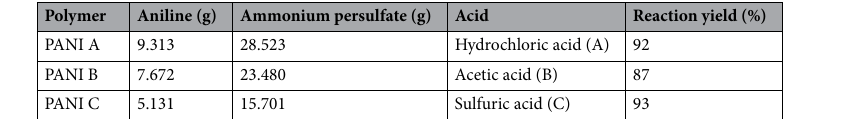
Table 1. Amounts of reagents used in the synthesis of